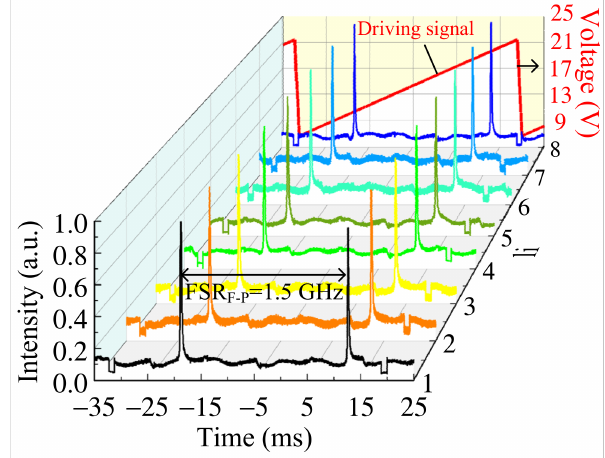
Figure 4. SLM operation performances of the eight single-wavelength operations measured by scanning the F-P interferometer.